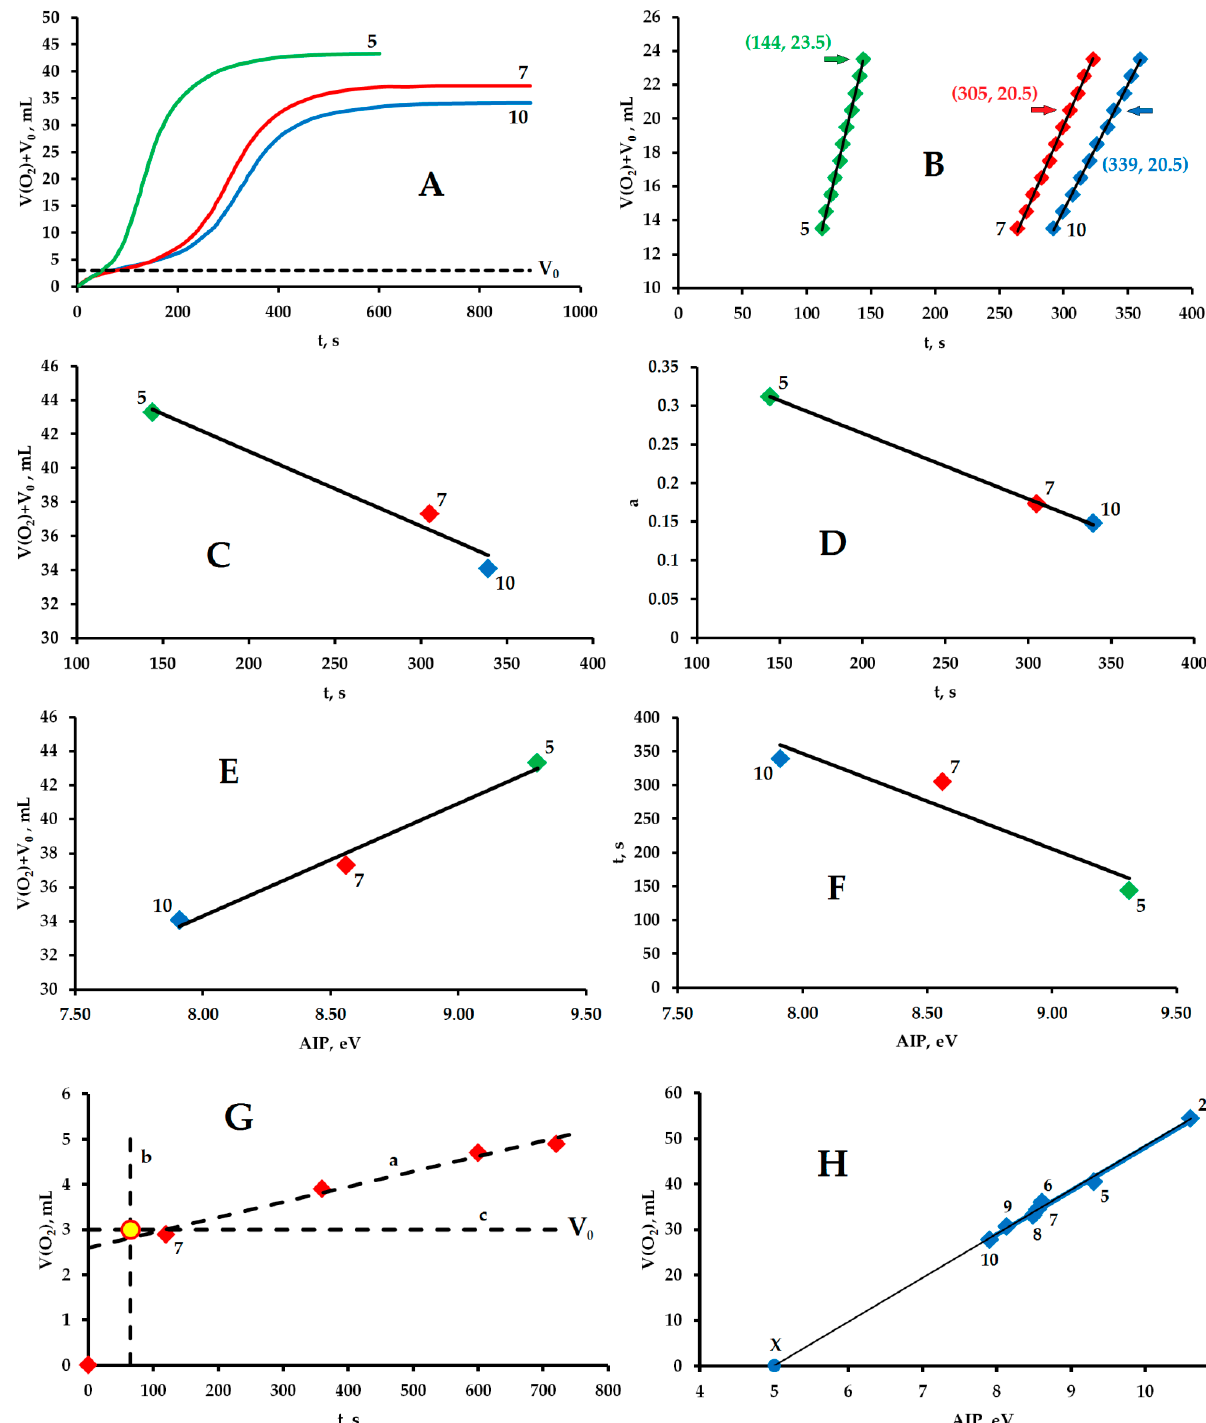
Figure 3. Kinetic curves ( A , B , G ) and correlations of their parameters with each other and with the AIP of hydrocarbons RH and H 2 O 2 ( C – F , H ). Equations of straight lines y = ax + b : ( A ): V 0 = 3 mL; ( B ): V(O 2 ) + V 0 = 0.312t − 21.522, R 2 = 0.9984 (RH 5 ), V(O 2 ) + V 0 = 0.1733t − 32.406, R 2 = 0.9989 (RH 7 ), V(O 2 ) + V 0 = 0.1481t − 29.85, R 2 = 0.9993 (RH 10 ); ( C ): V(O 2 ) + V 0 = –0.0441t + 49.808, R 2 = 0.9659; ( D ): a = –0.0008t + 0.4336, R 2 = 0.9996; ( E ): V(O 2 ) + V 0 = 6.6078AIP − 18.55, R 2 = 0.9825; ( F ): t = –141.21AIP + 1476.1, R 2 = 0.901; ( G ): (a) V(O 2 ) = 0.0034t + 2.5746, R 2 = 0.9841, (b) t = 65 s, (c) V 0 = V(O 2 ) = 3 mL; ( H ): V(O 2 ) = 9.624AIP − 48.117, R 2 = 0.9939.